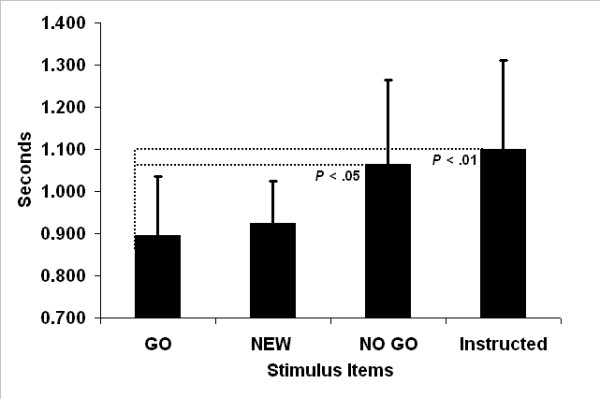
Reaction times during recognition memory. Group mean reaction times and standard deviations of recognition memory judgments exhibited during neuroimaging to stimulus items with different encoding histories. Encoding occurred prior to imaging and was prompted by three conditions (1) GO stimulus items: pressing a button to earn money under one set of stimuli; (2) NO-GO stimulus items: inhibiting button pressing under a second set of stimuli; and (3) Instructed stimulus items: memorizing a third set of stimuli as prompted by verbal instructions. The item labeled "NEW" was an asterisk presented during neuroimaging that prompted a button press and functioned as the baseline condition for assessing activation correlated with the onsets of encoded stimulus items (i.e., OLD > NEW contrasts). Significant differences in reaction times were observed between GO and NO-GO conditions and GO and Instructed conditions.